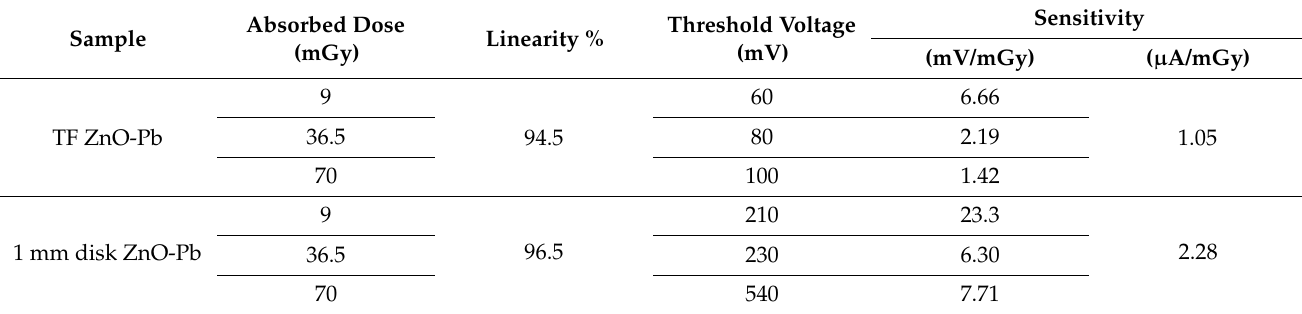
Table 2. Radiation sensing characteristics of ZnO-Pb under low radiation doses and various thicknesses.